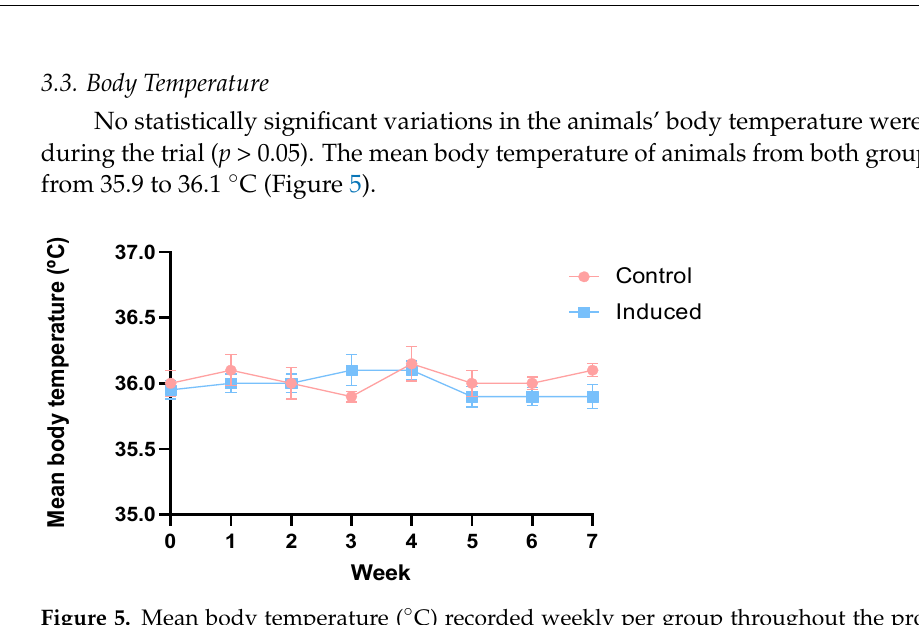
Figure 4. Welfare parameters changed in the induced animals throughout the experimental protocol. ( a ) Dehydration detected by the skin pinch test (black arrow); ( b ) lack of grooming (black arrow); ( c ) narrowing of the orbital area (evaluation of animal expression using the Grimace scale) (black arrow); ( d ) curved posture and isolation from the other animals in the cage (black arrow); ( e ) presence of pasty diarrhea; ( f ) di ff erence between distended abdomen (on the right) and normal abdomen (on the left).